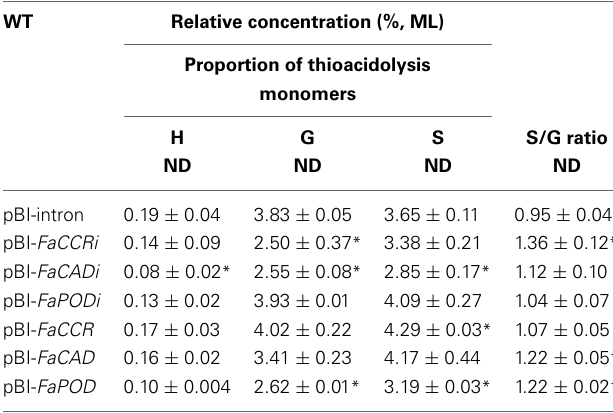
Table 2 | Impact of fruits injected with different constructs on lignin monomer composition.